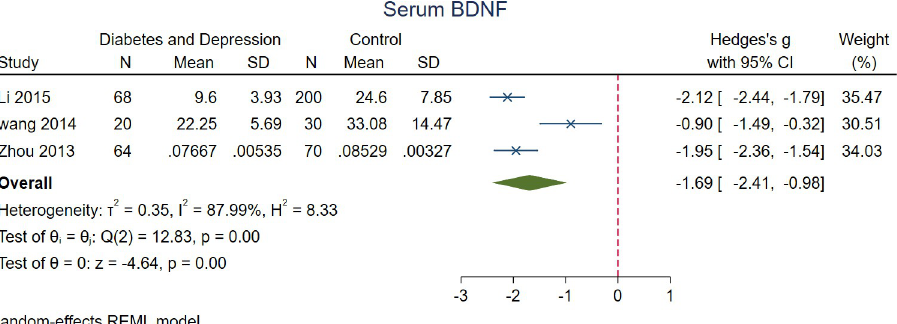
Fig 5. A meta-analysis of serum BDNF levels in patients with DM and depression vs.